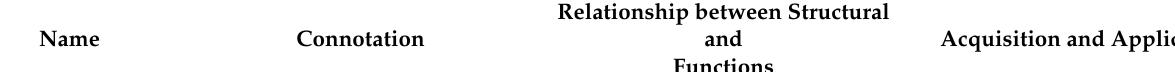
Table 1. Grading indexes of network elements and their data acquisition and